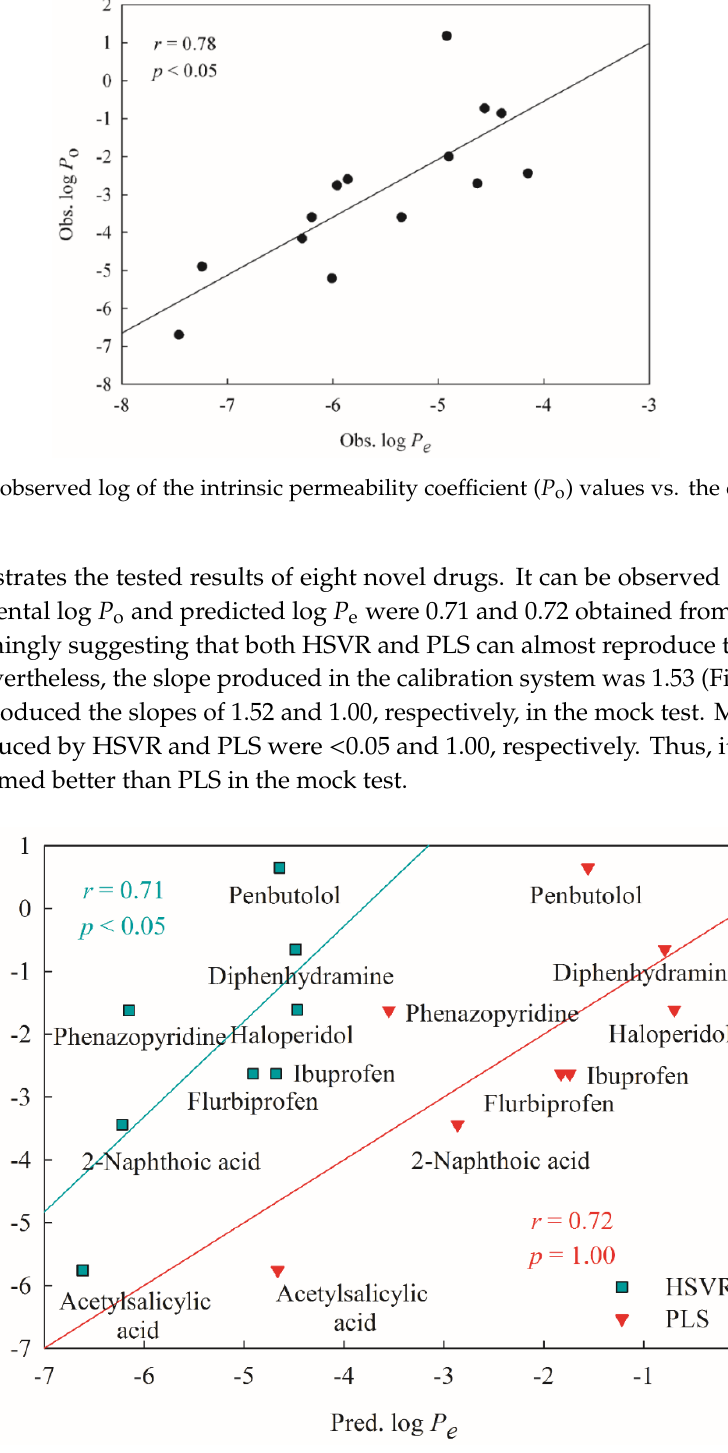
Figure 8. The observed log P o values vs. the log P e values predicted by HSVR (green square) and PLS (red triangle), and their regression lines.